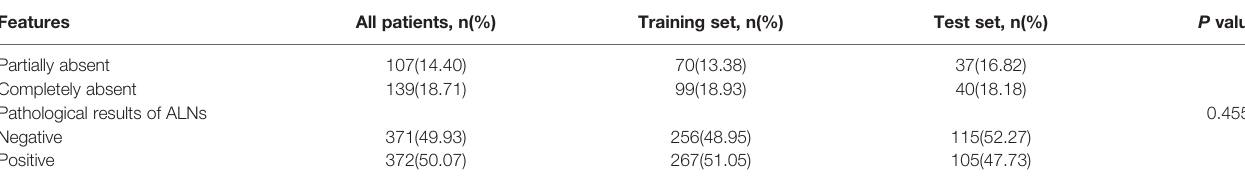
( Figure 3D ) correlated highly positively with ALN metastasis in the